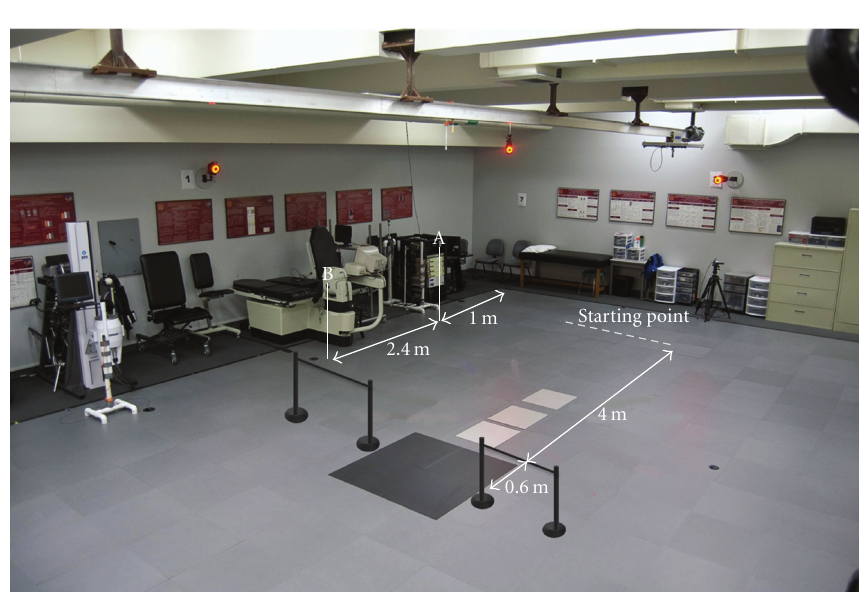
Figure 1: Laboratory setup. Dashed line: starting point; A: first trigger; B: second trigger; black square: force plate (AMTI 1.2m × 1.2 m, 1560 Hz). Two stanchions were placed at the midpoint of each force plate. Starting point to A: 1m. A to B: 2.4 m. B to force plate: 0.6 m. Force plate to stanchions: